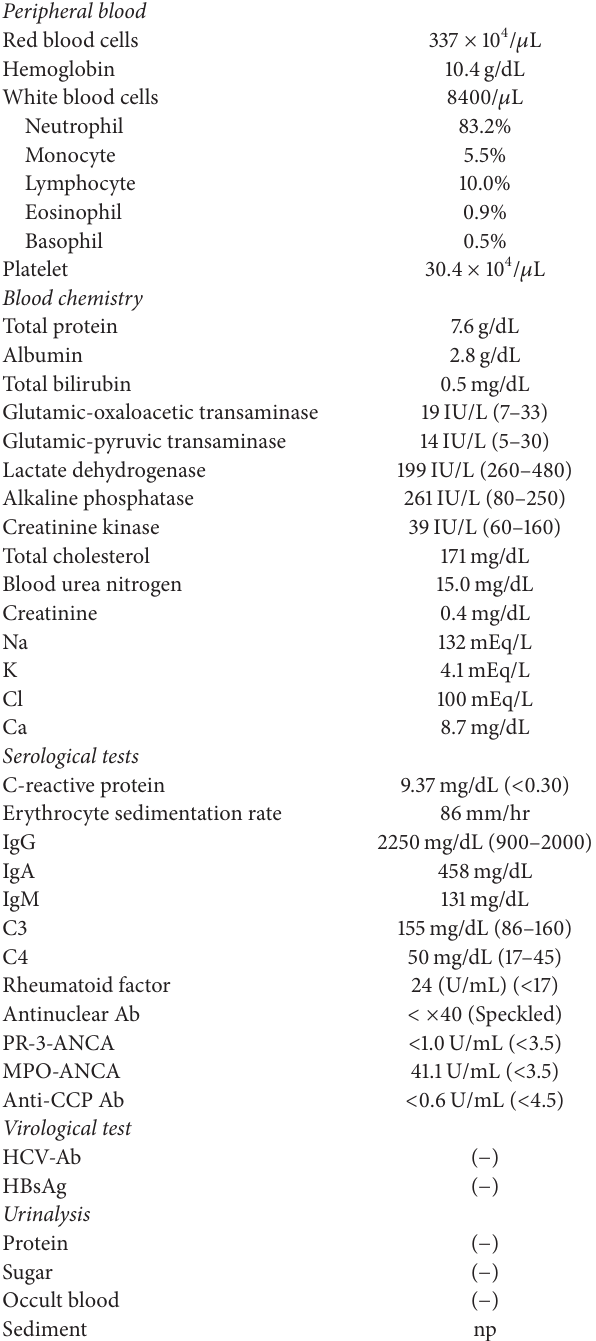
Table 1: Laboratory findings.